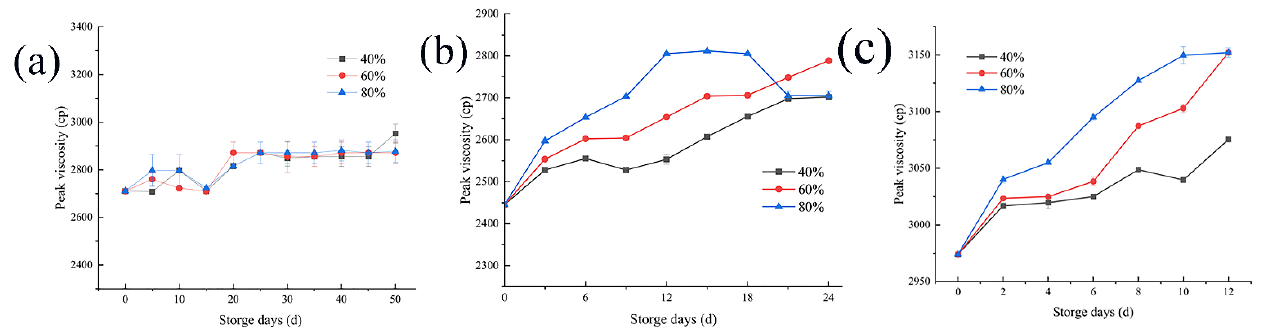
Figure 4. Peak viscosity of rice at storage temperatures of 20 ( a ), 30 ( b ), and 35 ( c ) °C under three different environmental relative humidity.